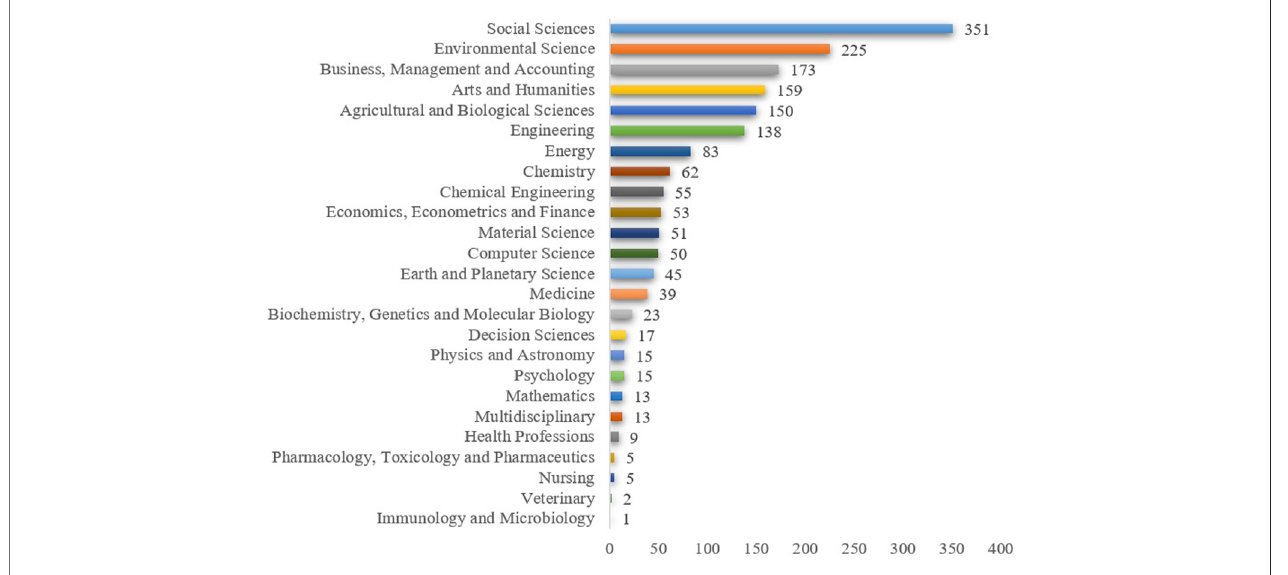
FIGURE 3 | Thematic areas in sustainable crafts. Source: Authors ’